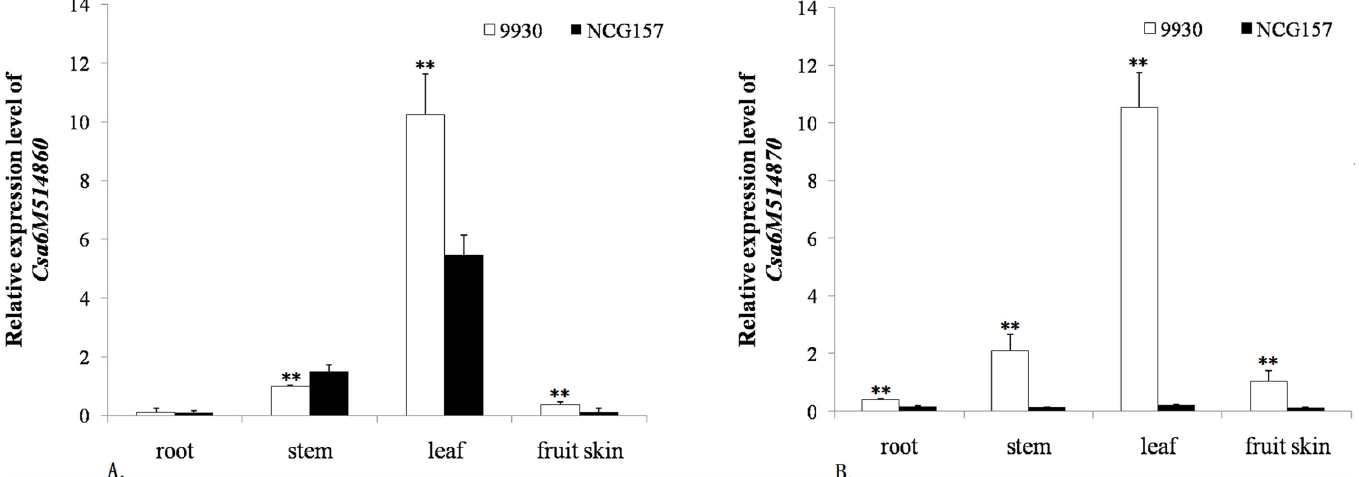
Fig 5. Relative expression levels of Csa6M514860 (A) and Csa6M514870 (B) in different tissues in 9930 and NCG157. Values are the mean ± SD (n = 3). ( ** indicates significant differences between 9930 and NCG157 at P = 0.01. Average in the graphs represents biological replicates).